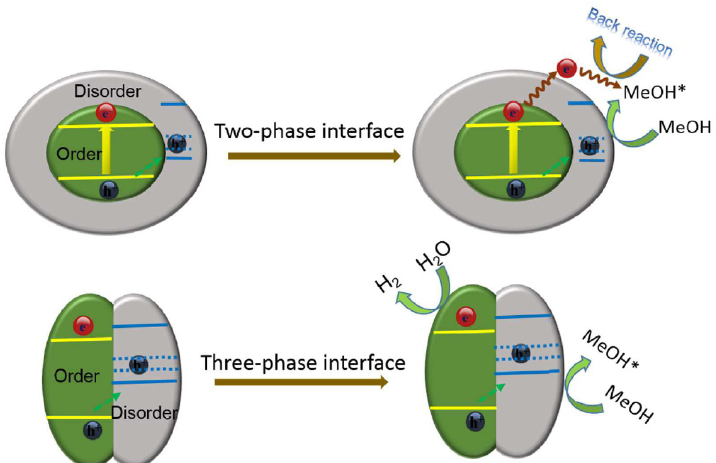
Figure 8. Proposed mechanism for charge separation and H 2 generation in conventional black TiO 2 ( top ) and blue P25 ( bottom ); green part: ordered TiO 2 , gray part: disordered TiO 2 . Reprinted with permission from [116]. Copyright 2016, Royal Society of Chemistry.